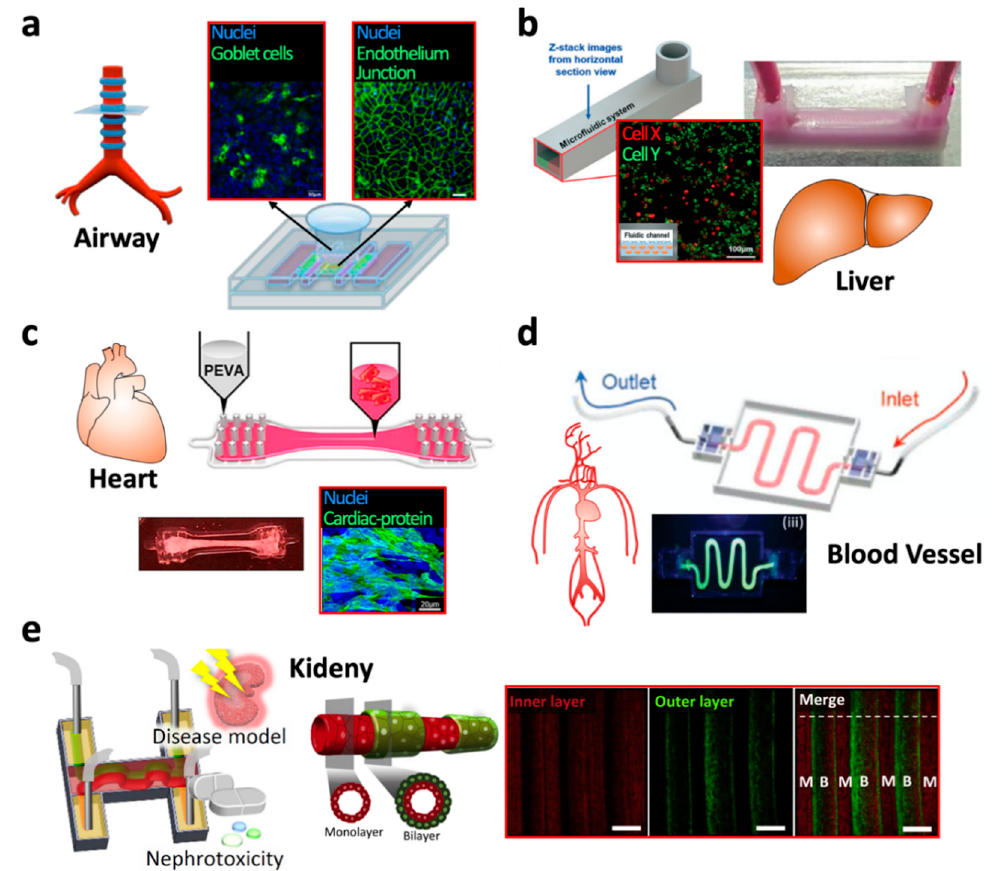
Figure 2. The 3D bioprinted in vitro models. ( a ) Airway-on-a-chip. The red-lined inset images indicate the formations of (left) epithelium with functional goblet cells and (right) endothelium in the chip. Adapted from Park et al. [129]. ( b ) Liver-on-a-chip. The red-lined inset image indicates a monolayer of red-dyed cells onto a bioink containing green-dyed cells. This arrangement was applied in the co-culture of endothelial cells (monolayer on the top) and hepatocytes (encapsulated in the bioink at the lower part). Adapted from Lee et al. [34]. ( c ) Bioprinted cardiac muscle. The red-lined inset image indicates the maturation of the cardiac muscle in the system. Adapted from Das et al. [20]. ( d ) Perfuable blood vessel-on-a-chip. Adapted from Gao et al. [130]. ( e ) Renal proximal tubule-on-a-chip. The red-lined inset images show a proximal tubule bilayered with renal epithelium (outer layer, green) and endothelium (inner layer, red). Adapted from Singh et al.